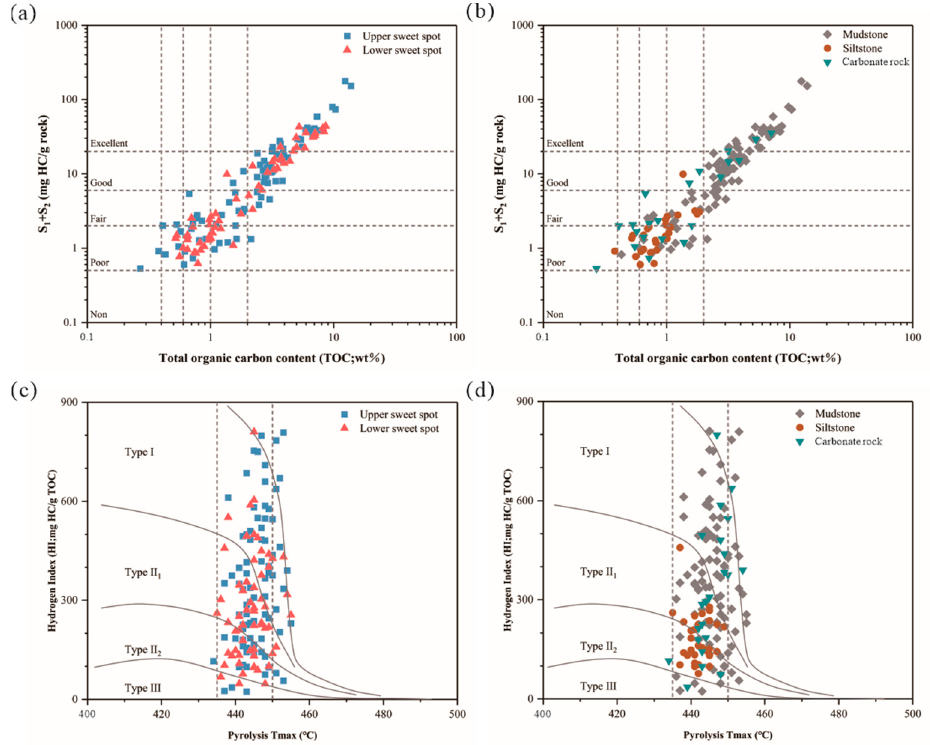
Figure 2. ( a ) Plot of the TOC content vs. S 1 +S 2 of the upper and lower sweet spots in the samples, to evaluate the hydrocarbon generation potential; ( b ) plot of the TOC content vs. S 1 +S 2 of mudstone, siltstone, and carbonate rock source rocks, to evaluate the hydrocarbon generation potential; ( c ) plot of HI vs. Tmax of the upper and lower sweet spot source rocks, to evaluate organic matter types; ( d ) plot